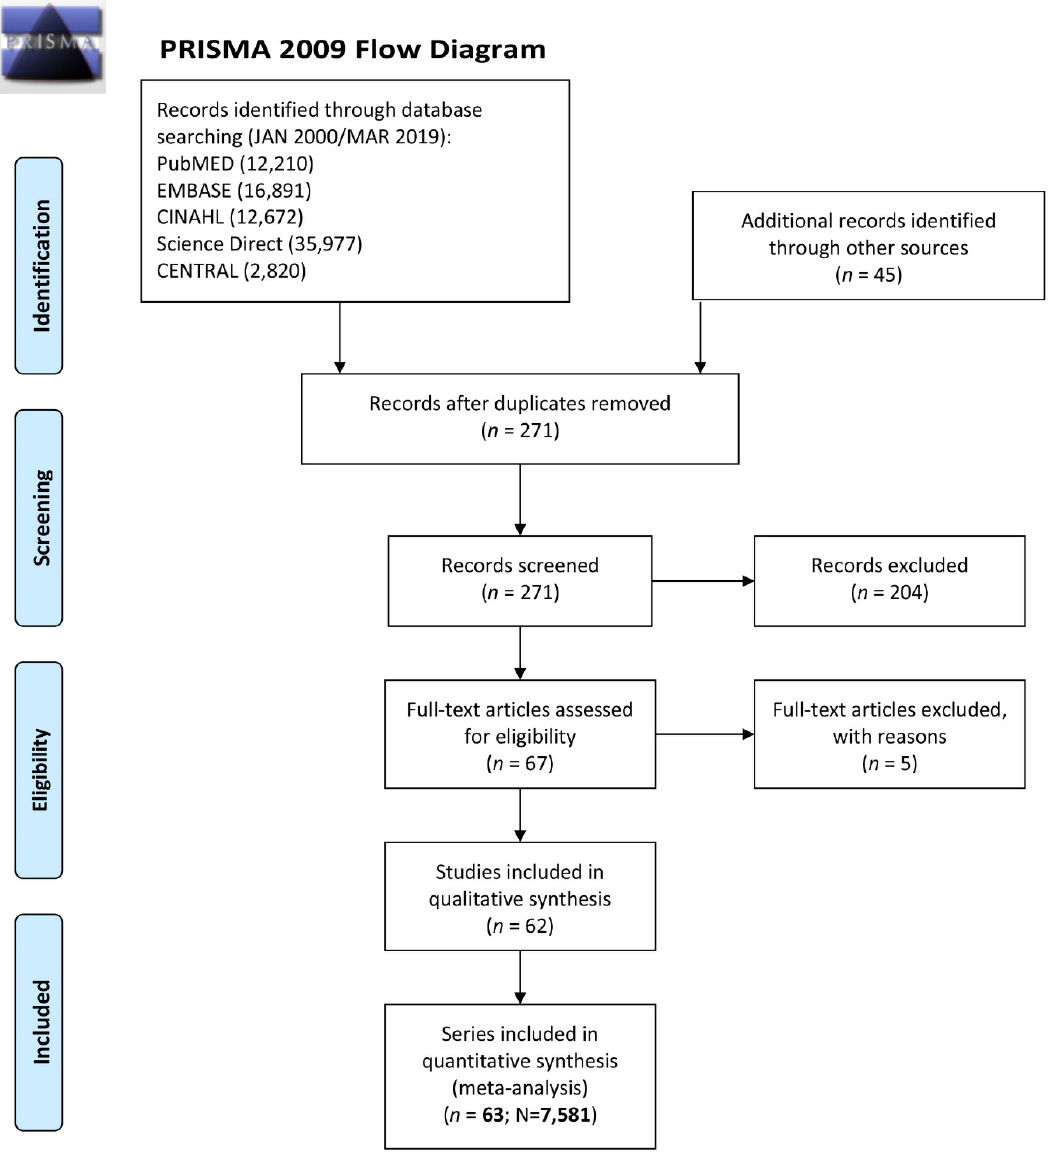
Figure 1. Preferred Reporting Items for Systematic Reviews and Meta-Analyses (PRISMA) flow diagram of study selection process. References of included and excluded studies are listed in the supplementary material.